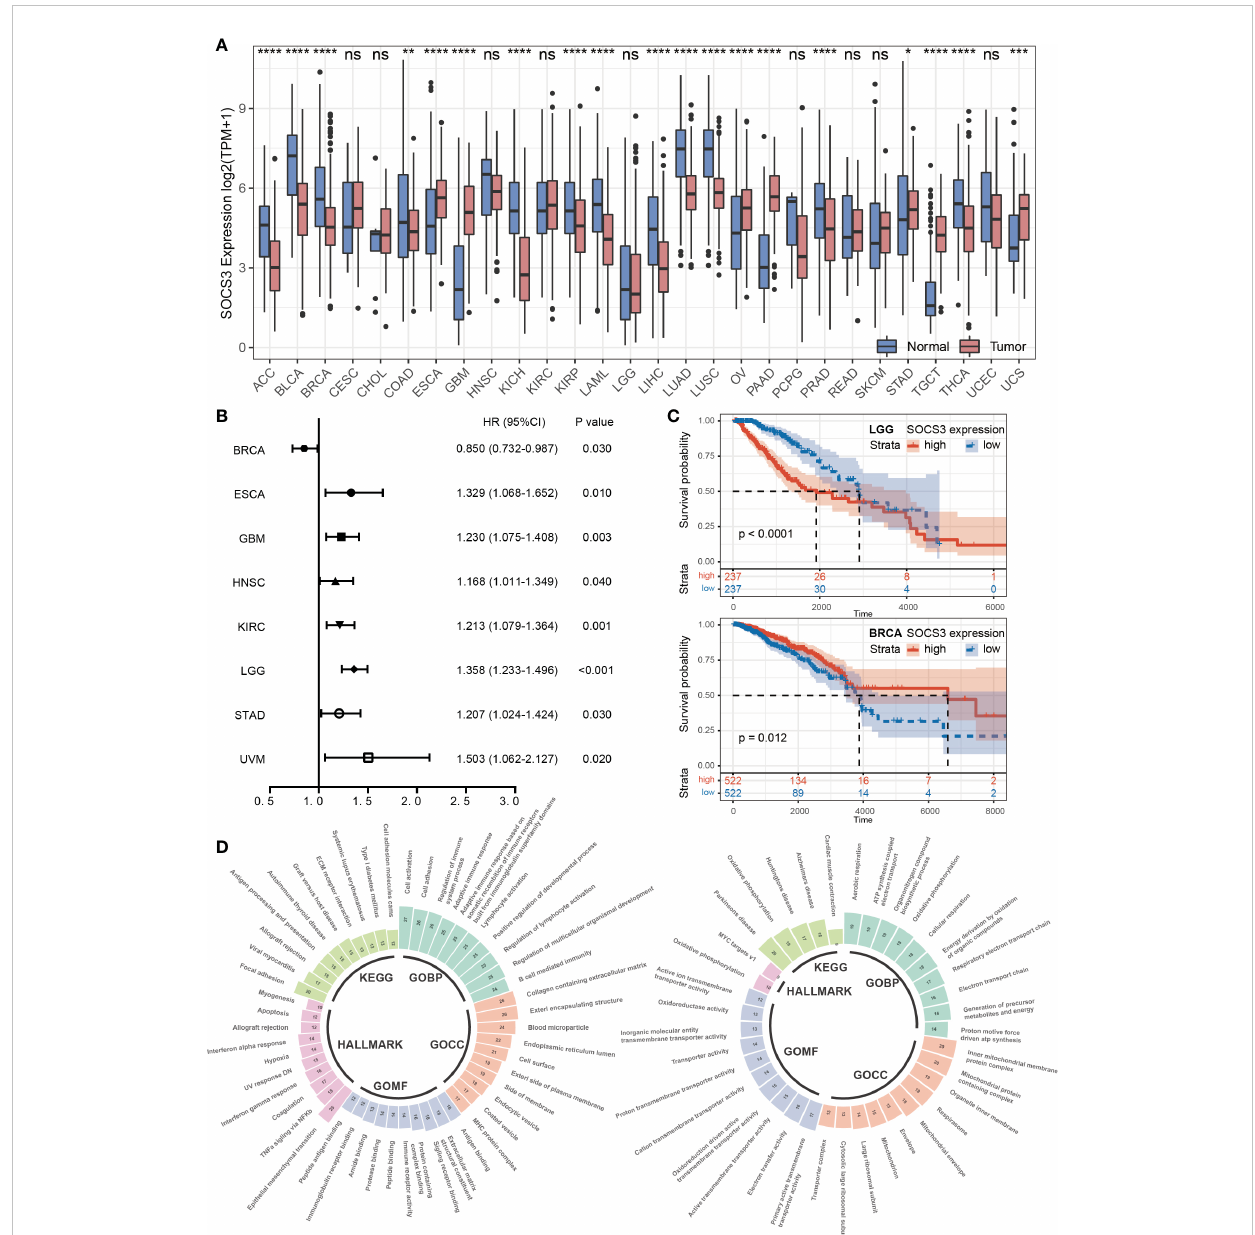
FIGURE 1 Pan-cancer expression pattern and prognostic performance of SOCS3. (A) The SOCS3 expression difference between cancer and corresponding non-tumor normal tissues in different tumors. *P < 0.05, **P < 0.01, ***P < 0.001, ****P < 0.0001. (B) The Cox proportional hazards regression analysis of SOCS3 in different tumors. (C) The Kaplan – Meier analysis in LGG and BRCA. (D) The consolidation of enrichment analysis of GO, KEGG and Hallmark pathway between the low SOCS3 group and high SOCS3 group in different tumors. The expanded form of "ns" is "no signi fi